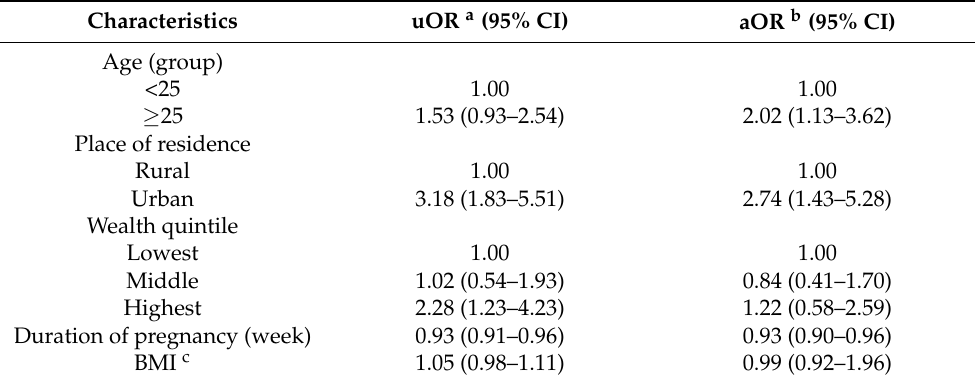
Table 2 legend. a uOR—unadjusted odds ratio. b aOR—adjusted odds ratio (model was adjusted for age, place of residence, wealth index, duration of pregnancy, and pre-pregnancy BMI). c BMI—prepregnancy body mass index (weight in kg/height in m 2 ) ( n = 257), calculated by subtracting 3 kg from the current weight for women up to 20 weeks of gestation and 3 kg plus 0.5 kg/week from their current weight for those over 20 weeks of